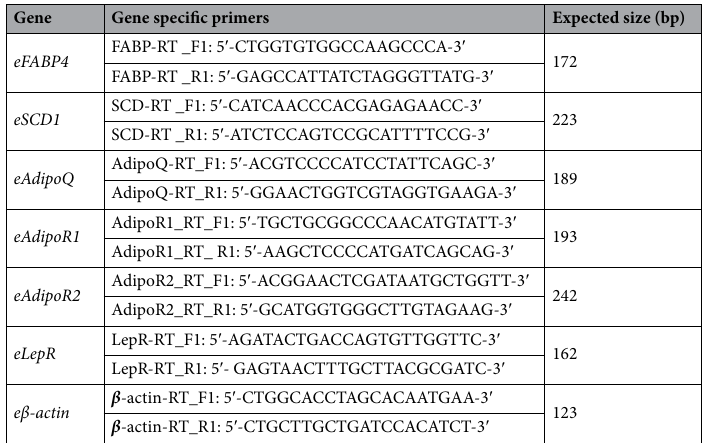
Table 3. Gene specific primers for amplifying the specific gene fragment of emu eFABP , eSCD-1 , eAdipoQ , eAdipoR1 , eAdipoR2 , eLepR and eβ-actin for quantitative real time PCR. eFABP4: emu Fatty Acid Binding Protein ; eSCD1: emu Stearoyl-CoA desaturase-1 ; eAdipoQ: emu Adiponectin ; eAdipoR1: emu Adiponectin Receptor1 ; eAdipoR2: emu Adiponectin Receptor2 ; eLepR: emu Leptin Receptor ; eβ-actin: emu